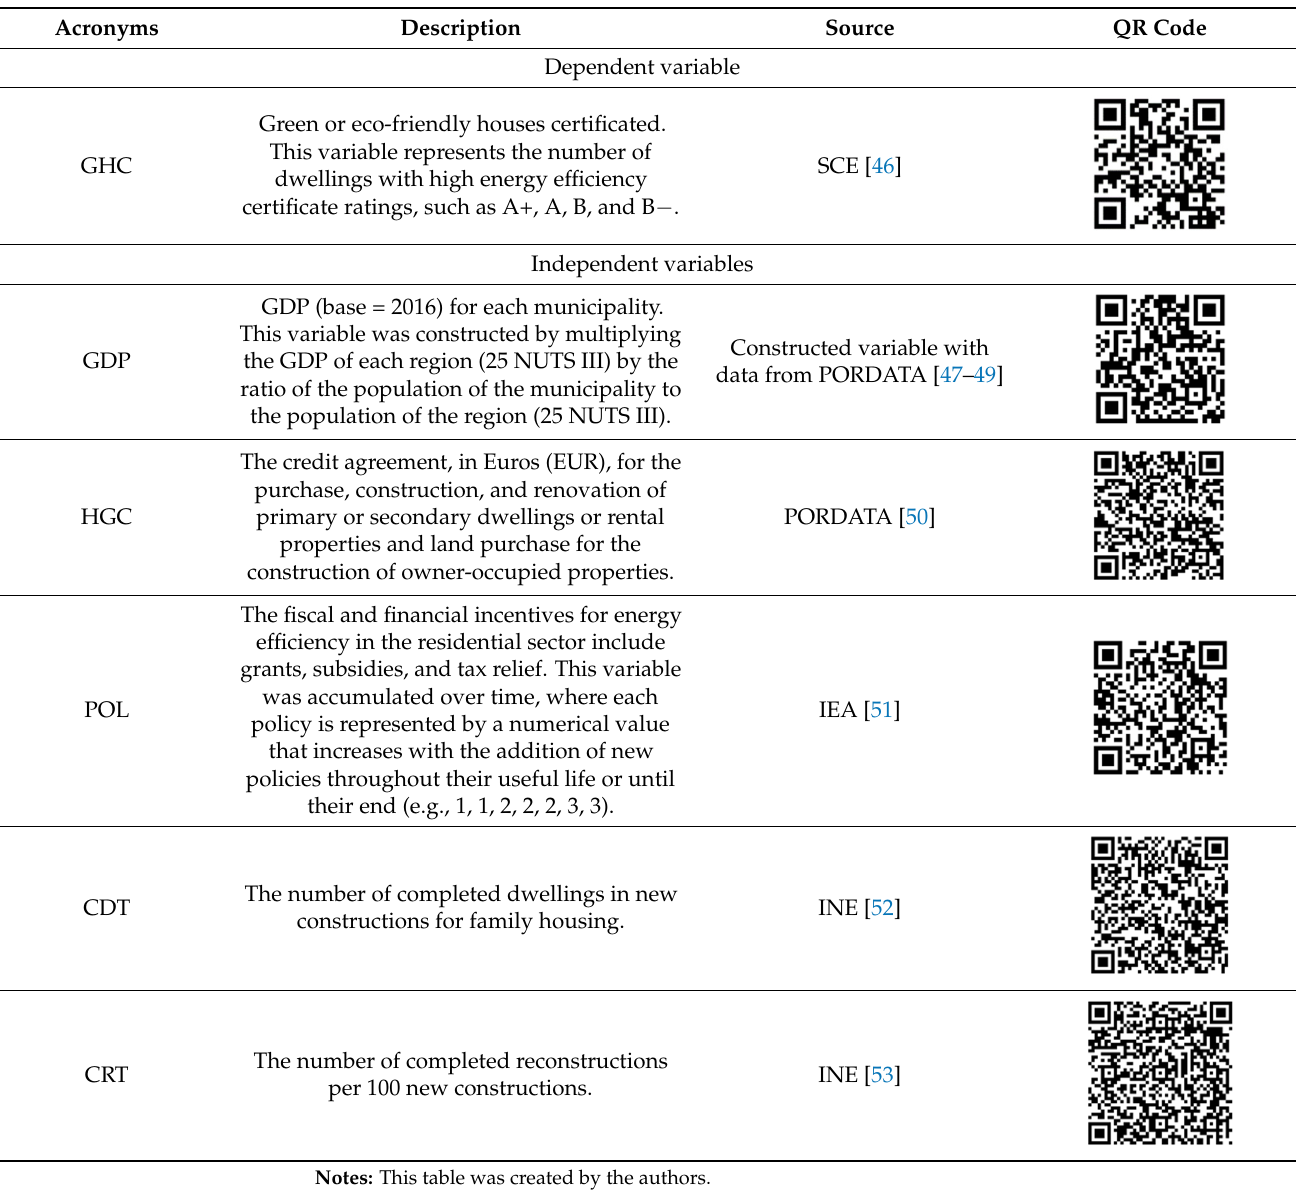
Table 2. Variable acronyms, descriptions, and sources.